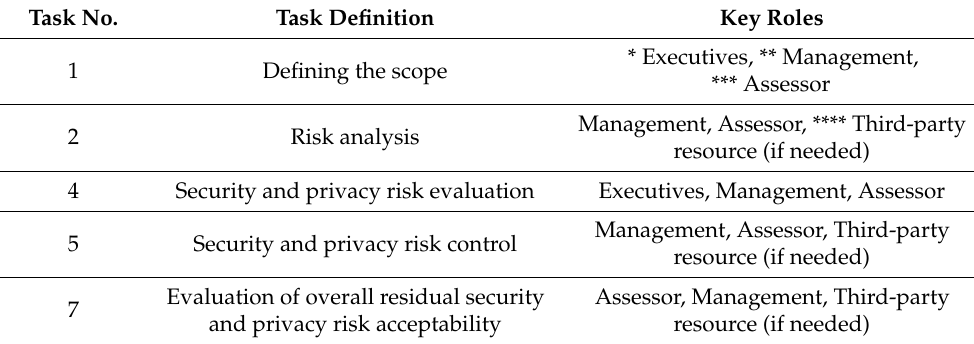
Table 4. Team structure for implementing the proposed framework. Task